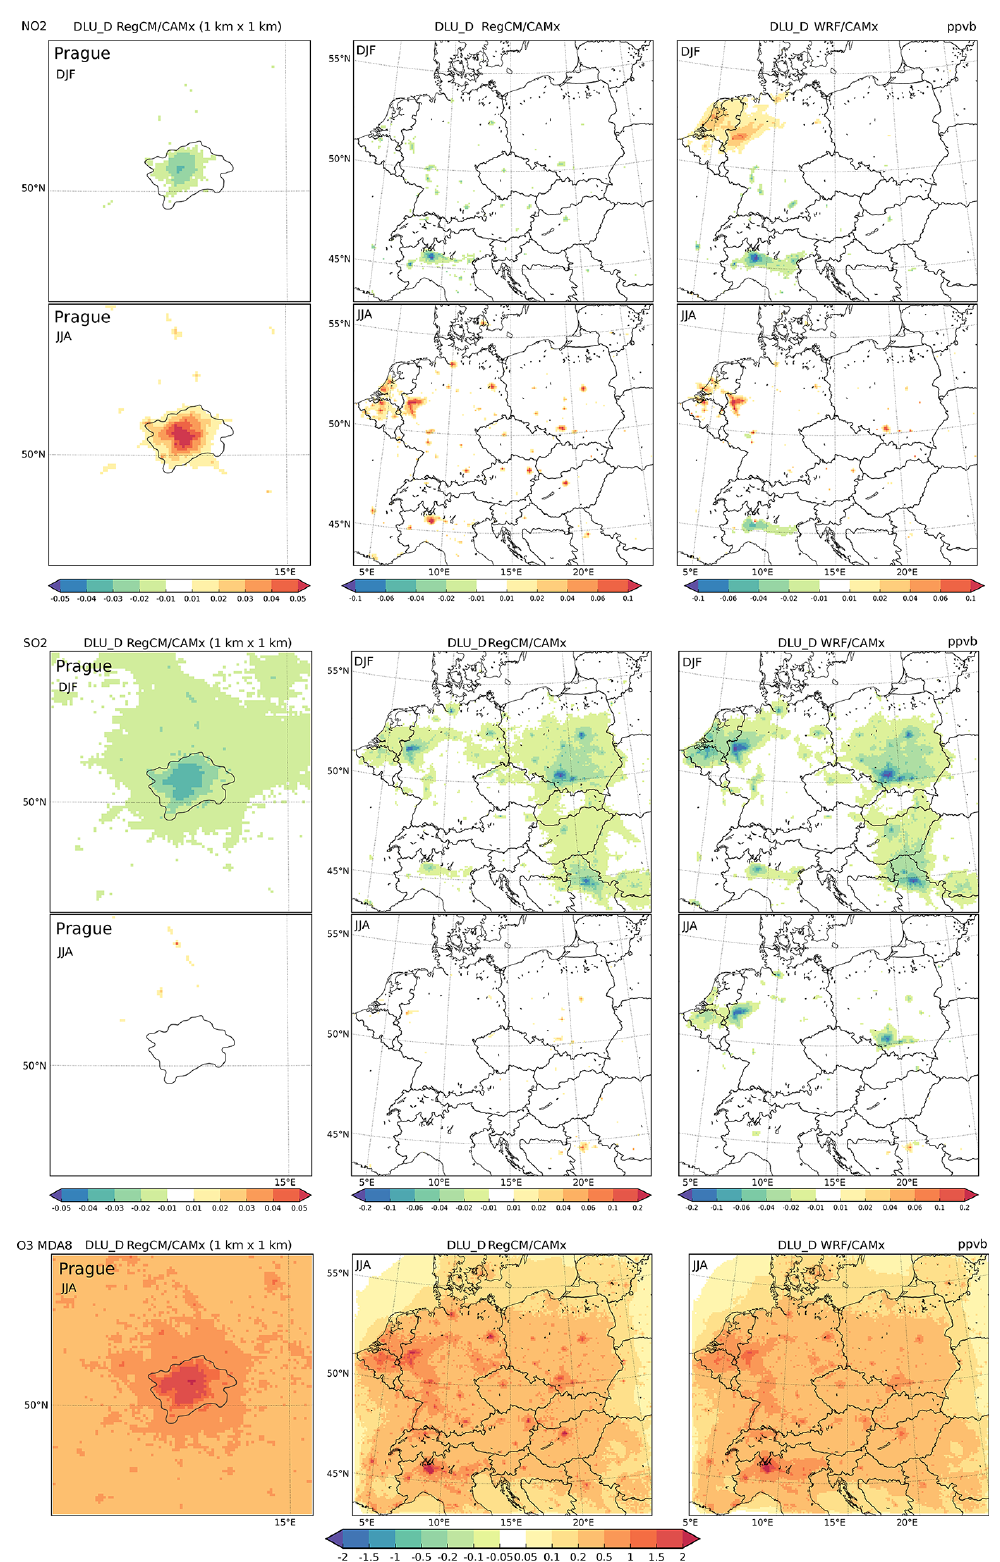
Figure 6. The spatial distribution of the 2015–2016 average impact of the urban land cover via dry deposition modifications (DLU_D) on NO 2 DJF and JJA (first and second row), SO 2 DJF and JJA (third and fourth row), and JJA MDA8 O 3 (fifth row). Columns represent the results from the 1km RegCM/CAMx (detail of Prague), 9km RegCM/CAMx, and 9km WRF/CAMx simulations. Units are in parts per billion by volume